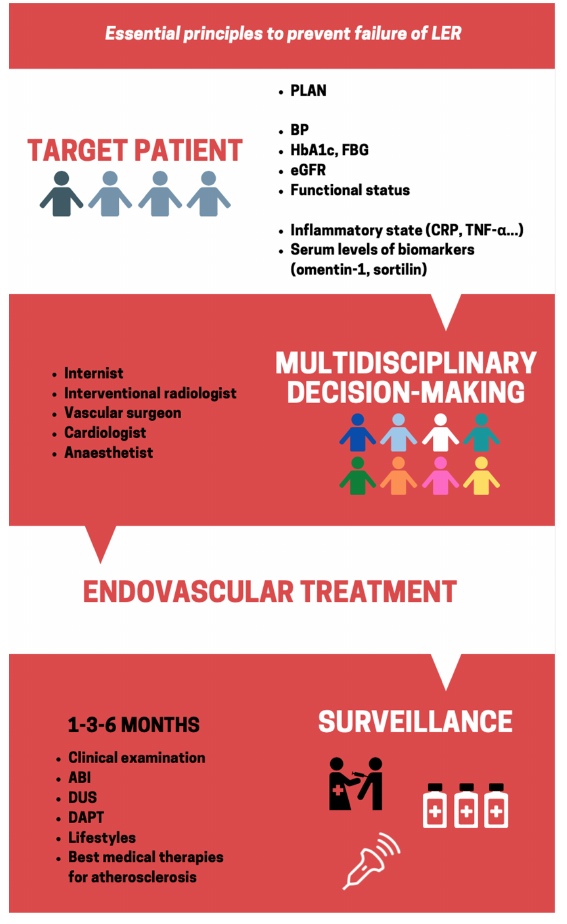
Figure 1. Essential principles to prevent failure of Lower extremity endovascular revascularization (LER). PLAN: Patient risk estimation, Limb severity, ANatomic disease patter; BP: blood pressure; HbA1c: glycated hemoglobin; FBG: fasting blood glucose; eGFR: estimated glomerular filtration rate; CRP: C-reactive protein; TNF- α : tumor necrosis factor- α ; ABI: ankle brachial index; DUS: duplex ultra sound; DAPT: dual antiplatelet therapy.